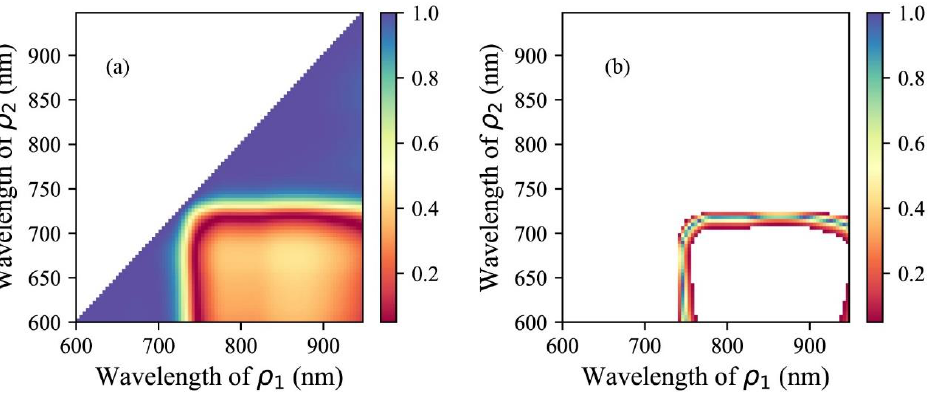
Figure 6. Comparisons of two-year measured LAI and simulated wheat LAI values based on four VIs- LUTs ( a ) NDVI-LUT in 2018, ( b ) ARVI-LUT in 2018, ( c ) MCARI2-LUT in 2018, and ( d ) NRI-LUT in 2018; ( e ) NDVI-LUT in 2019, ( f ) ARVI-LUT in 2019, ( g ) MCARI2-LUT in 2019, and ( h ) NRI-LUT in 2019. R 2 represents the coefficient of determination for a linear regression model between the measured LAI and simulated LAI.